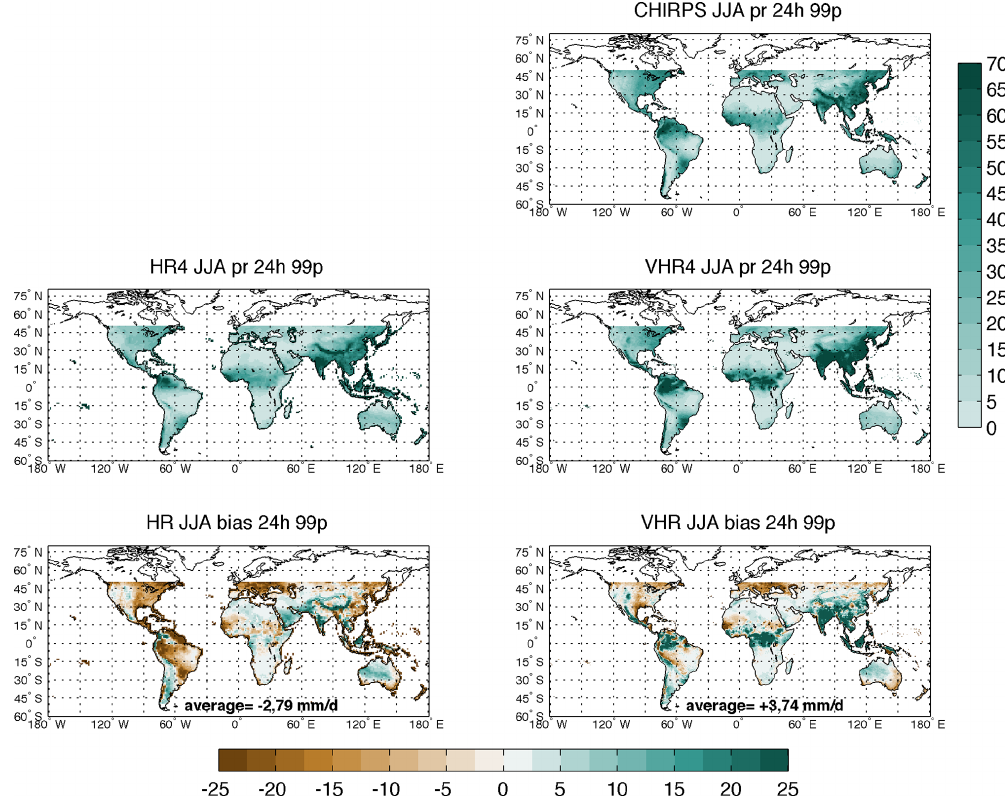
Figure 10. Same as Fig. 6 but based on CHIRPS observation. Summer (JJA) extreme precipitation (99th percentile, 99p) computed at the daily frequency. Upper panel shows CHIRPS observational results. Central panels show model results (HR on the left and VHR on the right) and lower panels show the relative model bias. Units are [mmd − 1 ]. Vertical color bar refers to the three upper panels, while the horizontal color bar refers to the two bottom